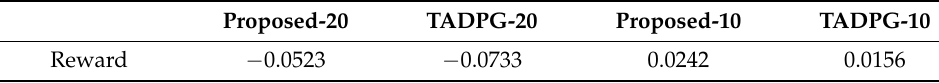
Table 3. Reward and variation comparison.